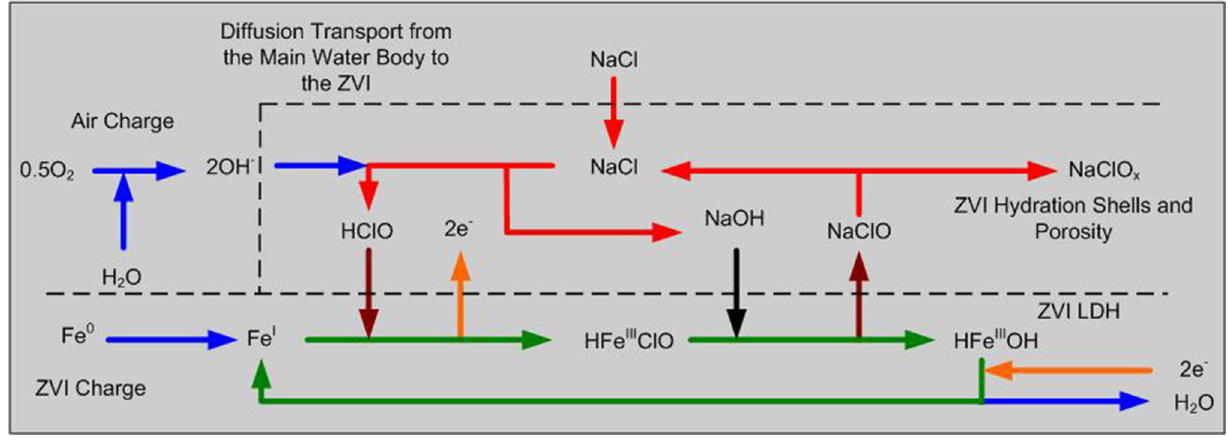
Fig. 10 Catalyst B: simplified schematic diagram illustrating the interaction of OH with the ZVI. LDH layered double